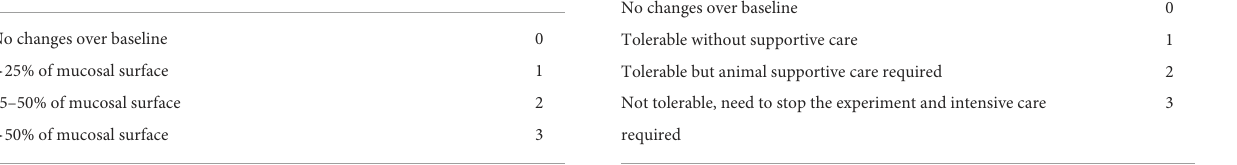
TABLE 2 Criteria for tolerability